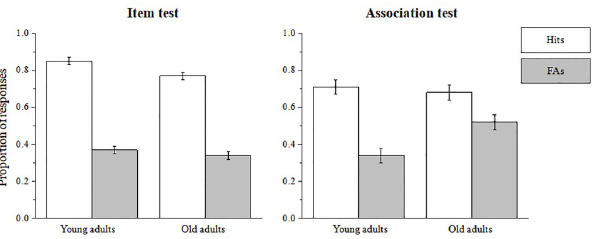
Fig 3. Hit and FA rates as a function of age (young/old adults) and test (item/association). Error bars represent the standard error of the mean.